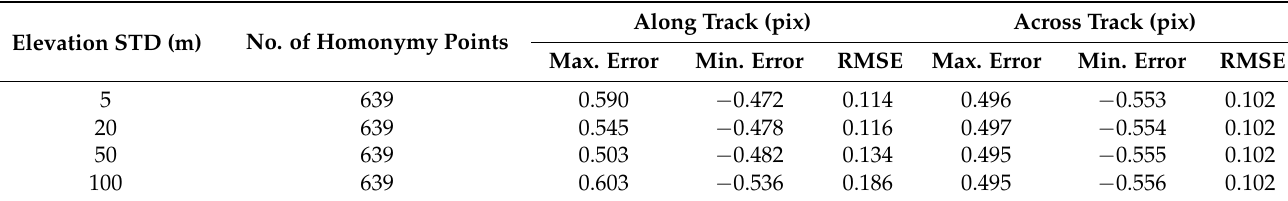
Table 5. Relative orientation residual of EA-stable-2 (left-middle